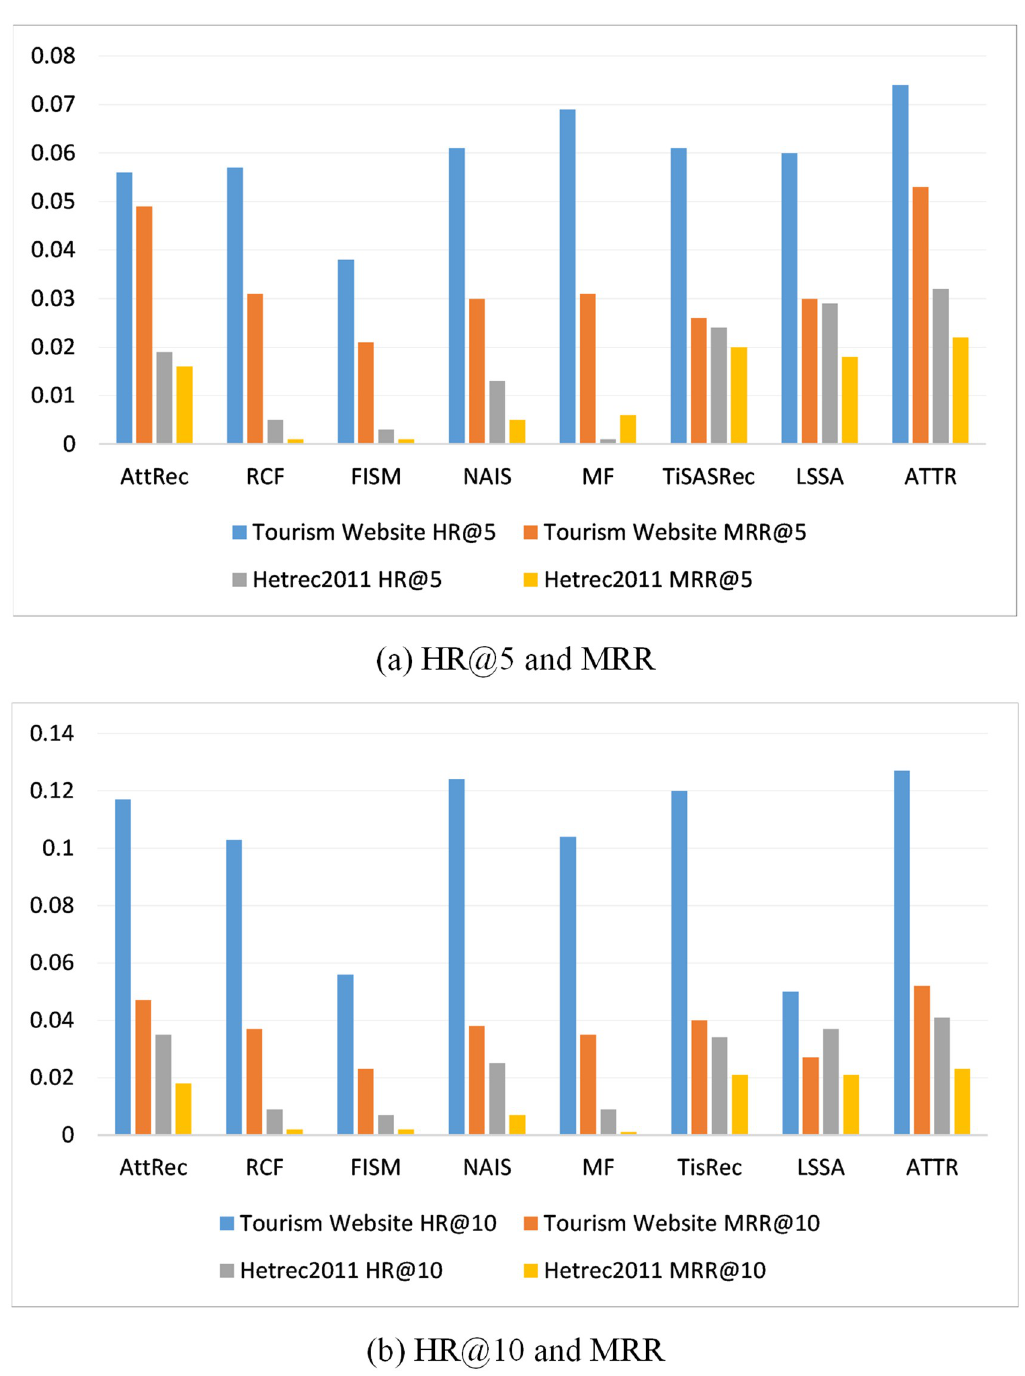
Fig 4. Histograms comparing the model with other baselines in the case ofthe top- k ( k =5,10)recommendations, respectively. From the figure, it is clear that the model introduced in this paper achieves the best performance on both datasets.